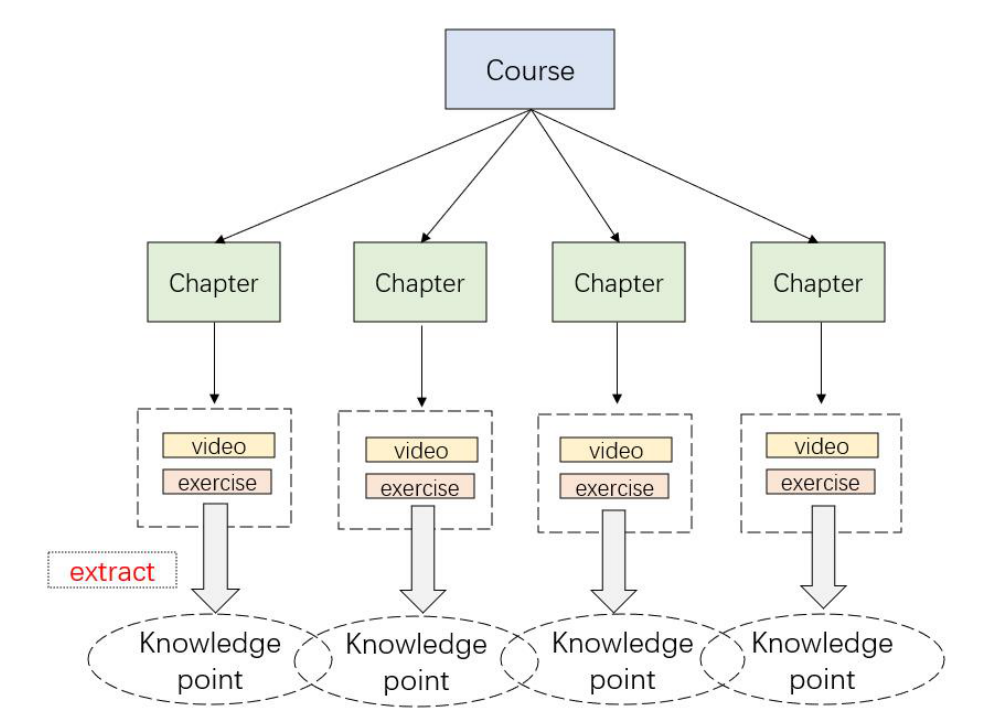
Figure 1. Content hierarchy of course